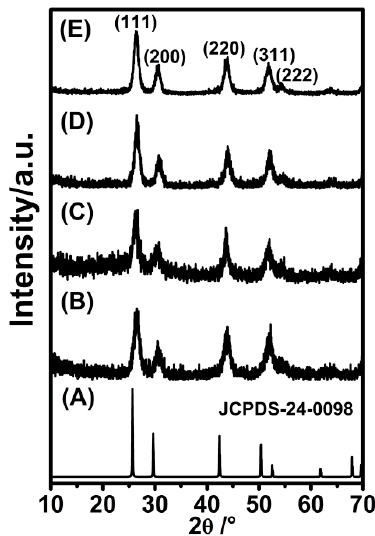
Figure 1. X-ray powder diffraction (XRD) patterns of ( A ) standard BaGdF 5 NPs (the vertical bars denote the standard data for tetragonal structure of bulk BaGdF 5 NPs (JCPDS-24-0098)); ( B ) BaLuF 5 :18%Yb 3+ ,2%Er 3+ core NPs; ( C ) BaLuF 5 :18%Yb 3+ ,2%Er 3+ ,2%Ce 3+ core NPs; ( D ) BaLuF 5 :18%Yb 3+ ,2%Er 3+ @BaLuF 5 :5%Yb 3+ core-active-shell NPs; and ( E ) BaLuF 5 :18%Yb 3+ ,